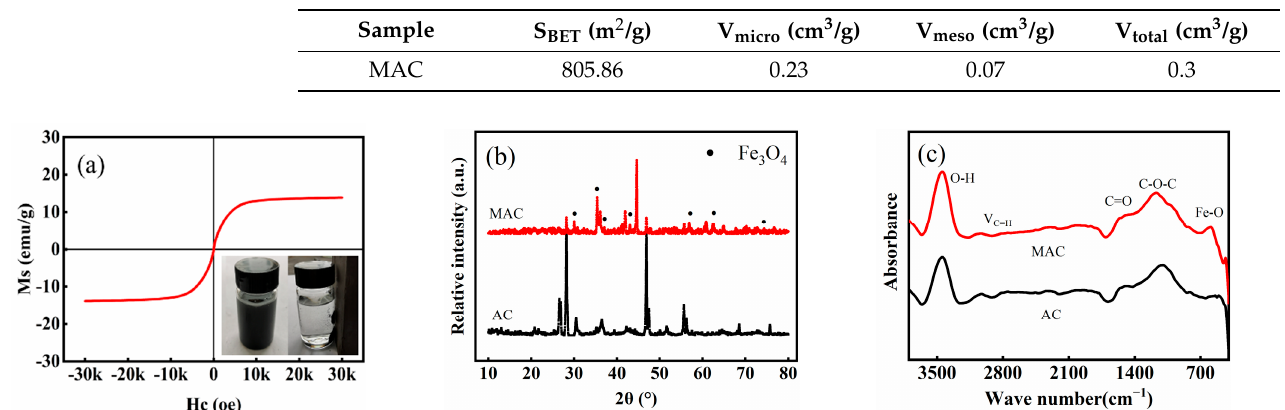
Table 2. Structural parameters of MAC.